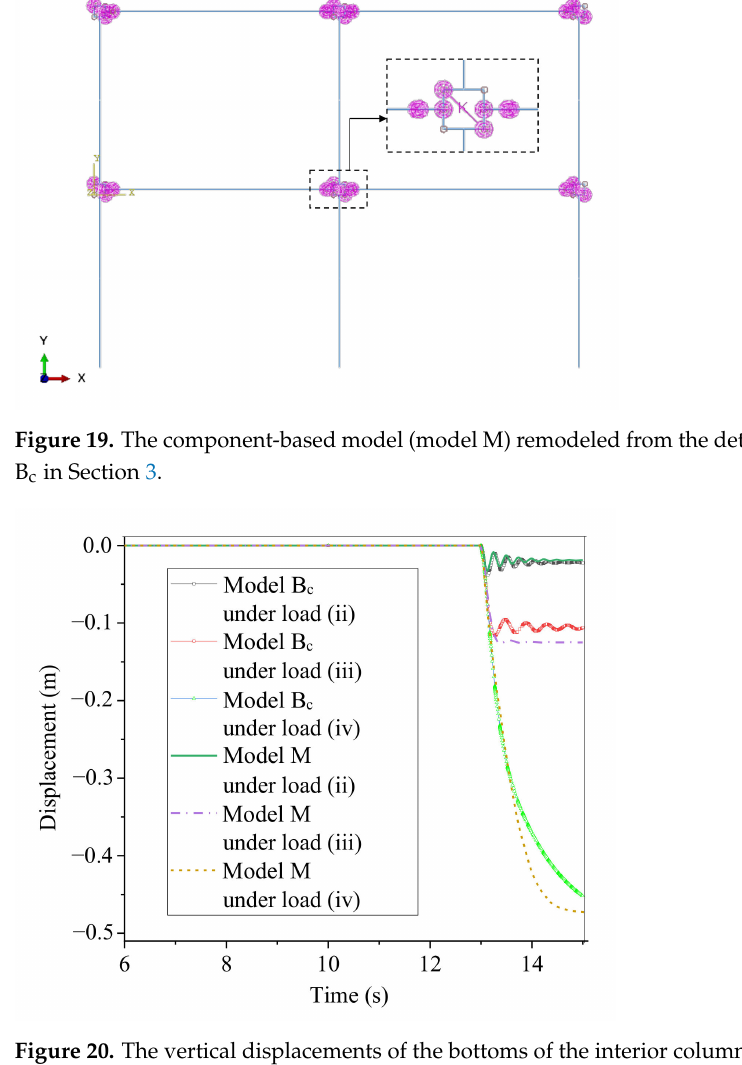
Figure 20. The vertical displacements of the bottoms of the interior columns in the component-based model (model M) and the detailed solid-element model (model B c